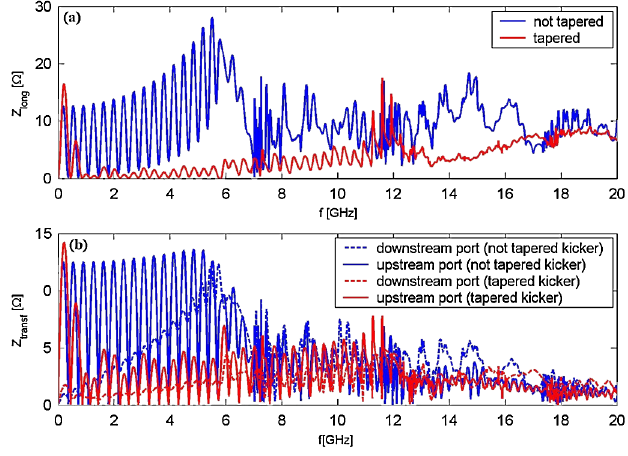
FIG. 15. The longitudinal beam coupling impedance and the transfer impedance calculated by GDFIDL